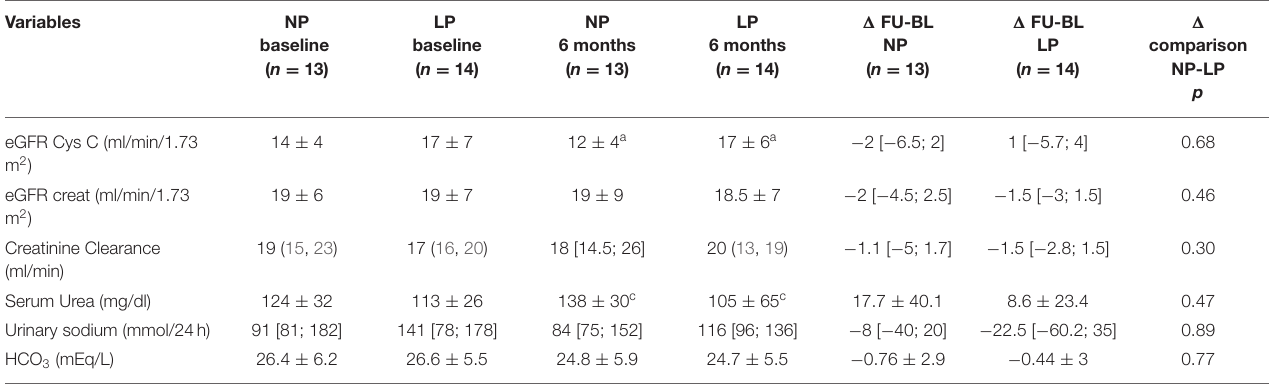
TABLE 4 | Kidney function and metabolic parameters (baseline vs. 6 months).